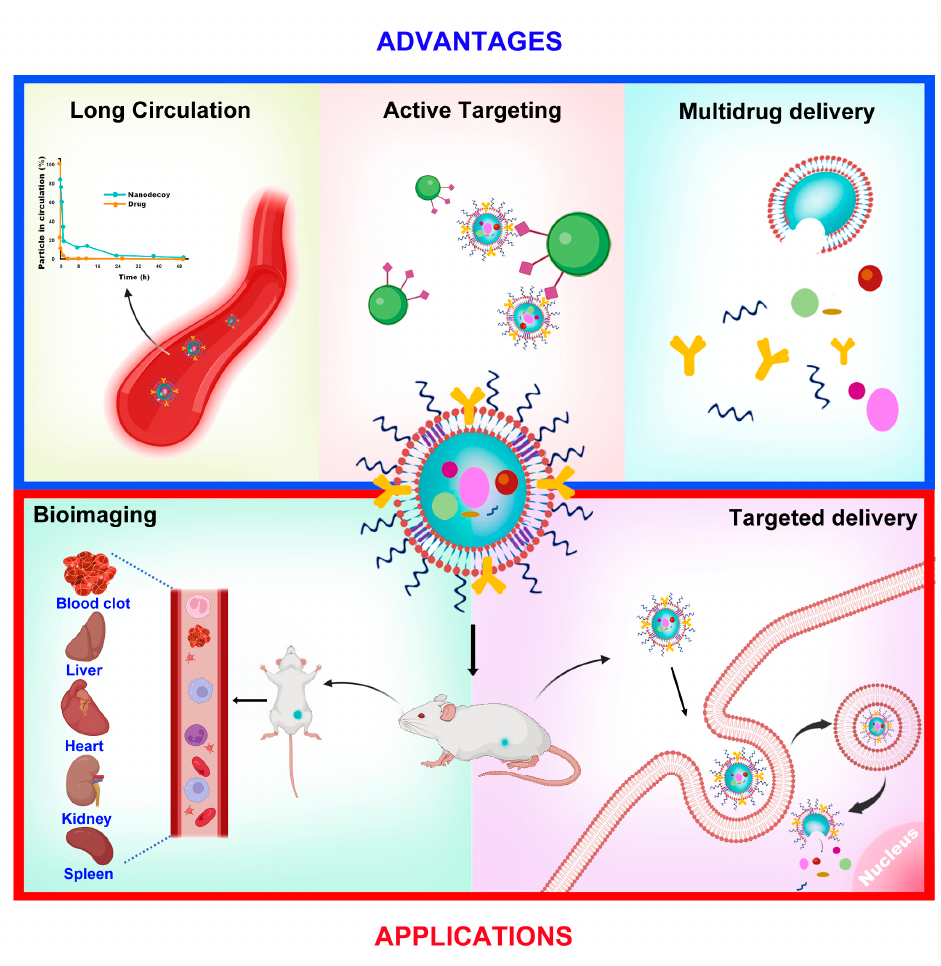
Figure 3. The advantages and theranostic applications of nanodecoys.